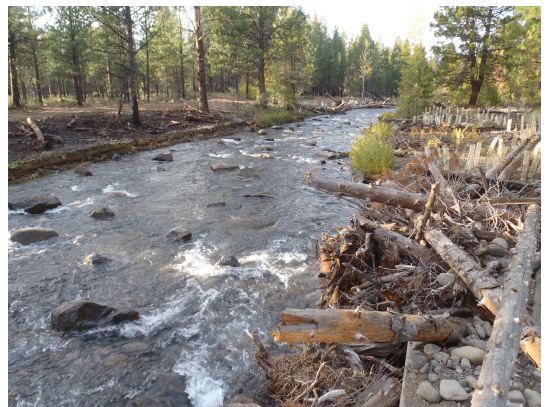
Figure 9. Constructed riffle on Whychus Creek, Oregon.